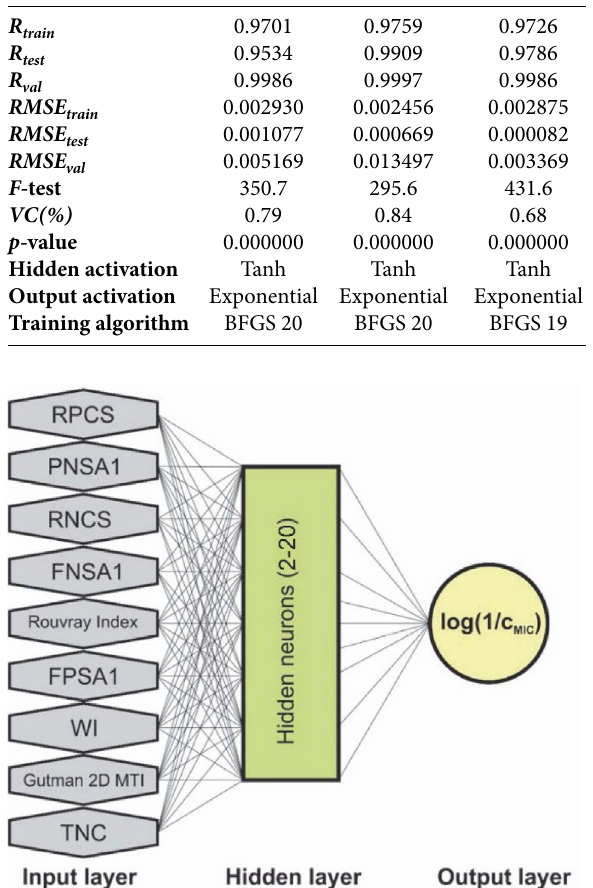
Figure 2. The general architecture of the established QSAR–ANN models.